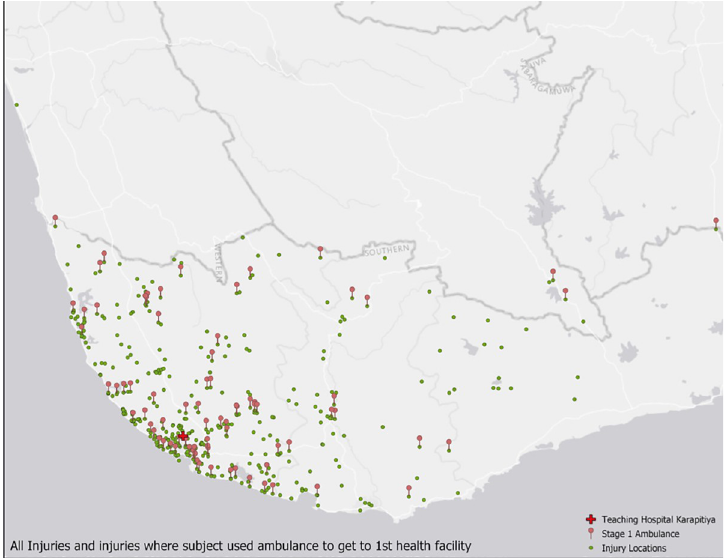
Fig 1. Injury locations and ambulance transport. Map depicting locations where injury event occurred (green dots, n = 400) and locations of injuries where patient took an ambulance to the first health facility (red pins, n = 83 of 400). The injury locations for 5 patients could not be mapped, thus n =